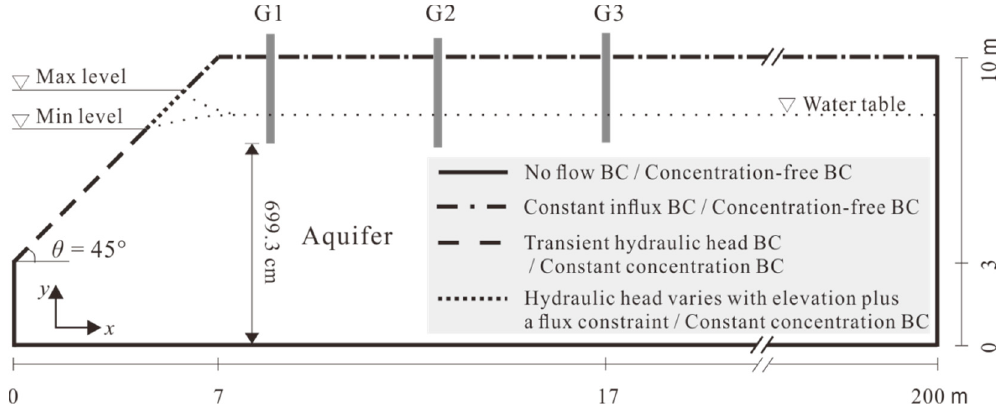
Figure 1. A transversal 2D conceptual model of the riparian zone downstream of Xin’an River Dam. G1, G2 and G3 respectively represent water-level monitoring wells. Flow from left to right is defined as positive, and vice versa.